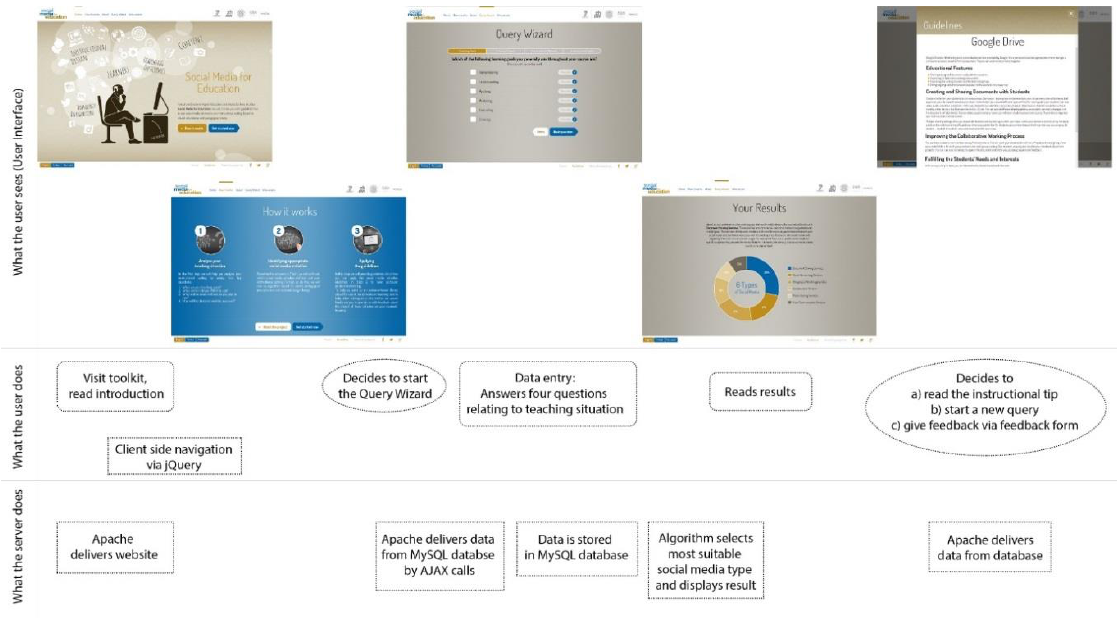
Figure 2. The functioning of the Social Media